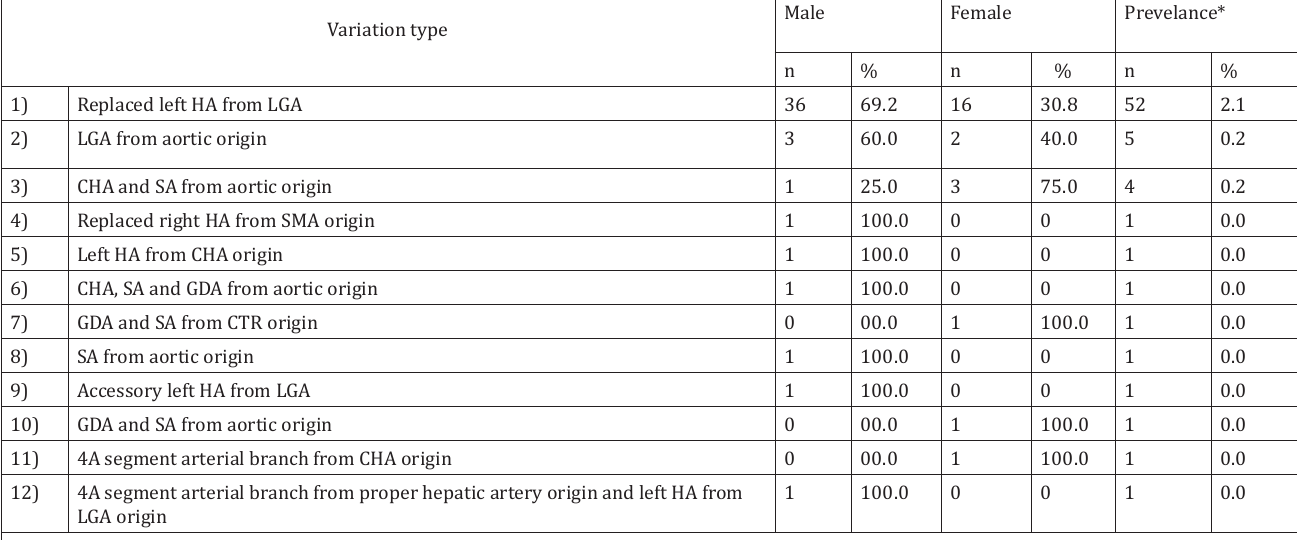
Frequency distribution of cases with double variation (co-variation, n =